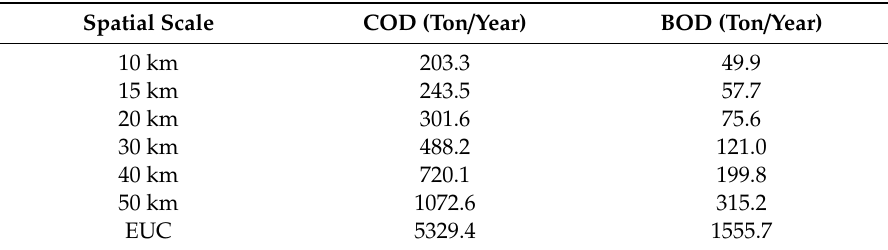
Table 6. The total amount of COD and BOD from sewage outfalls in seven spatial scales over the research